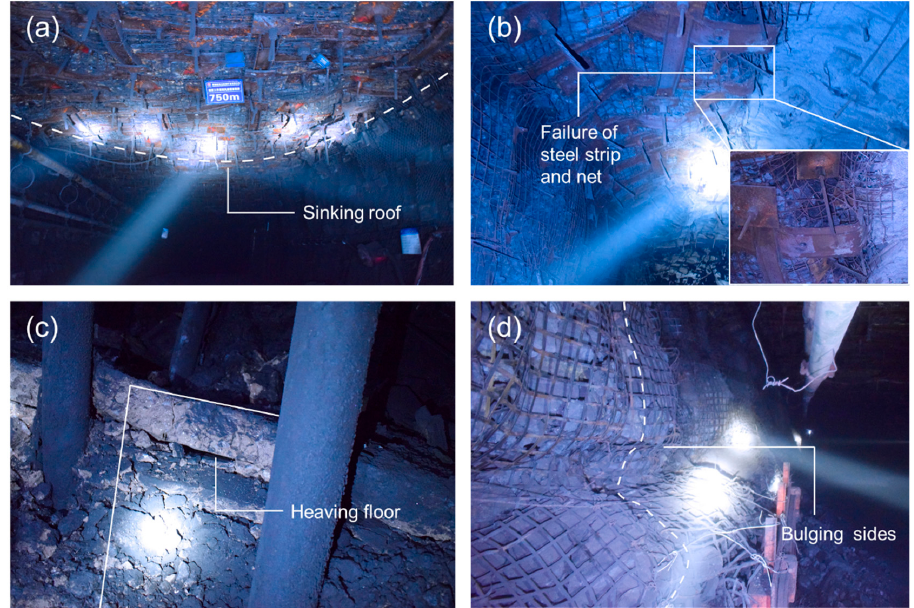
Figure 5. Field photos of roadway deformation and failure: ( a ) roof subsidence; ( b ) failure of supporting material; ( c ) floor heave; and ( d ) large bulging of the sides.